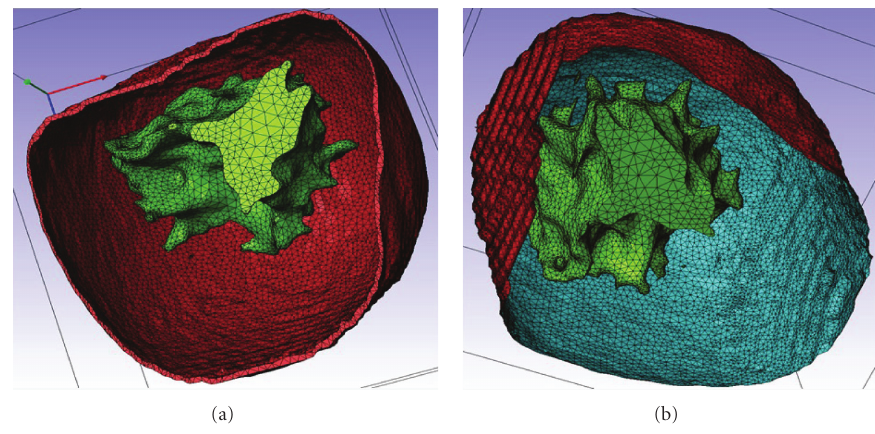
Figure 5: Meshes of the glandular and skin tissues for the two cases under study: (a), considering real skin and, (b), considering the skin as a